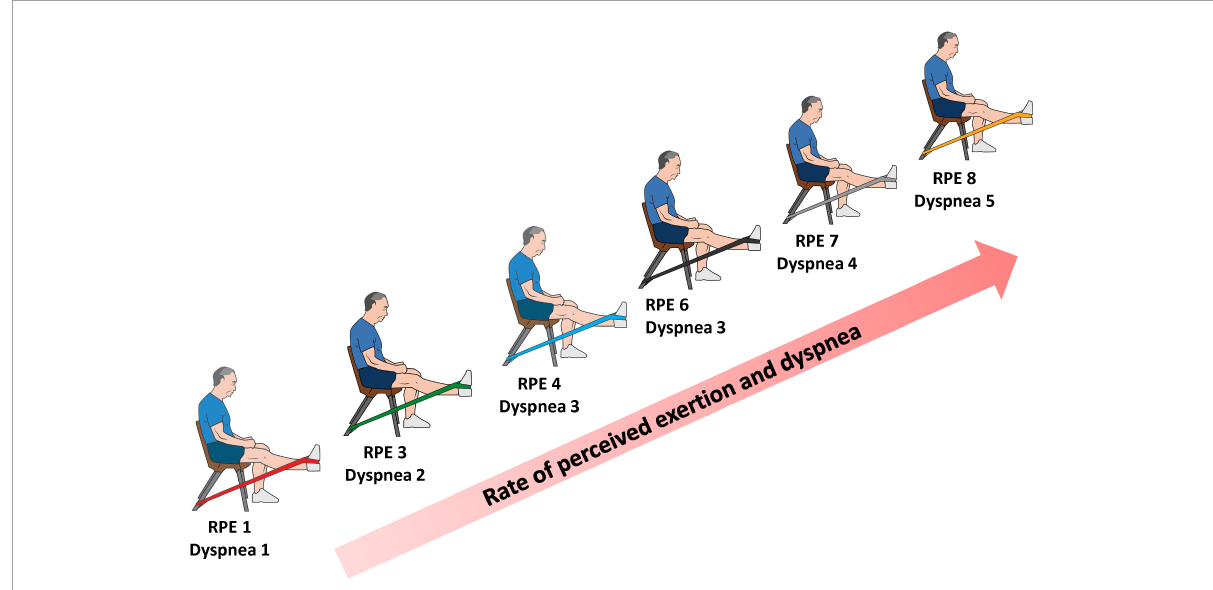
FIGURE2 Diagram representation of rate of perceived of exertion (RPE) and dyspnea during incremental elastic resistance exercise.